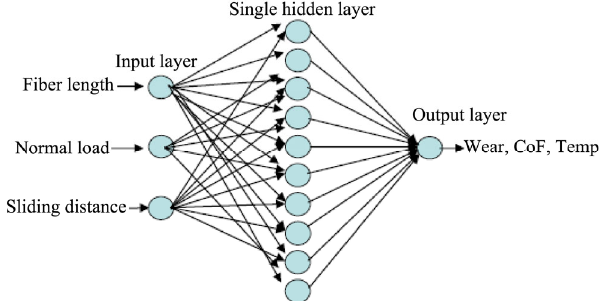
Fig. 10 Schematic of single hidden layer ANN model used in present study.